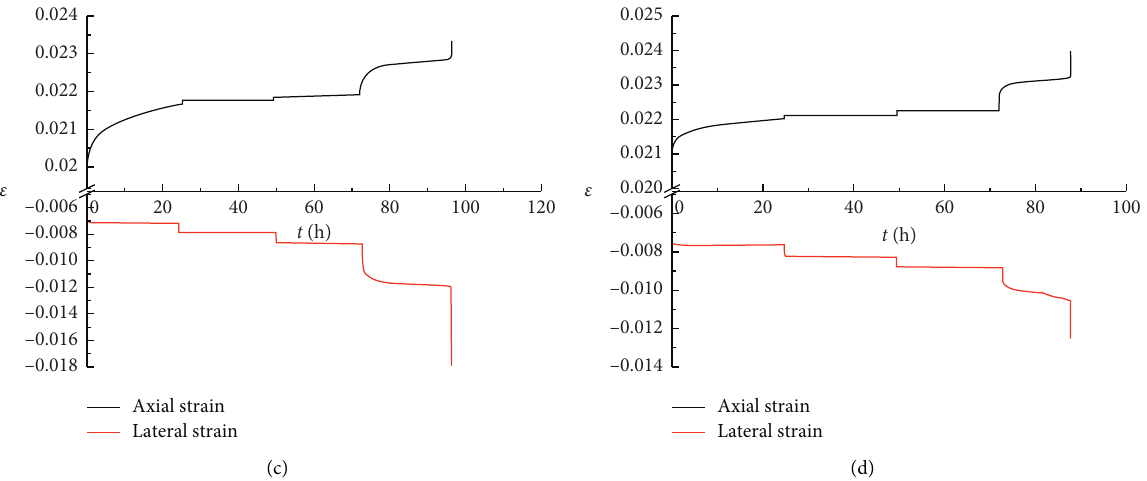
Figure 3: Axial and lateral creep curves of coal samples with different fracture dip angles. (a) A00 ( σ